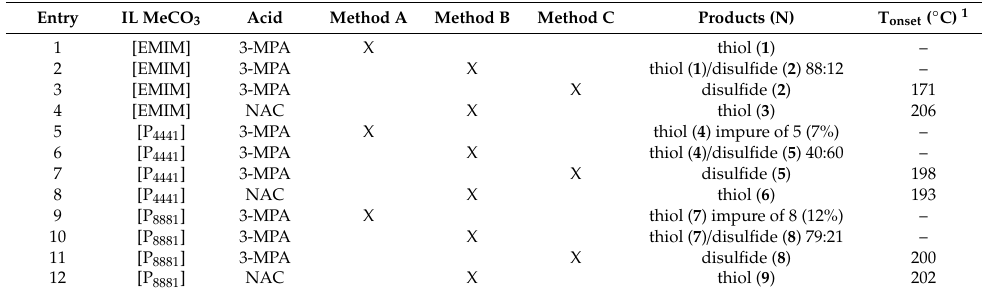
Table 1. Thiol carboxylate ILs and dianionic disulfide ILs and their mixture obtained by methods A–C.